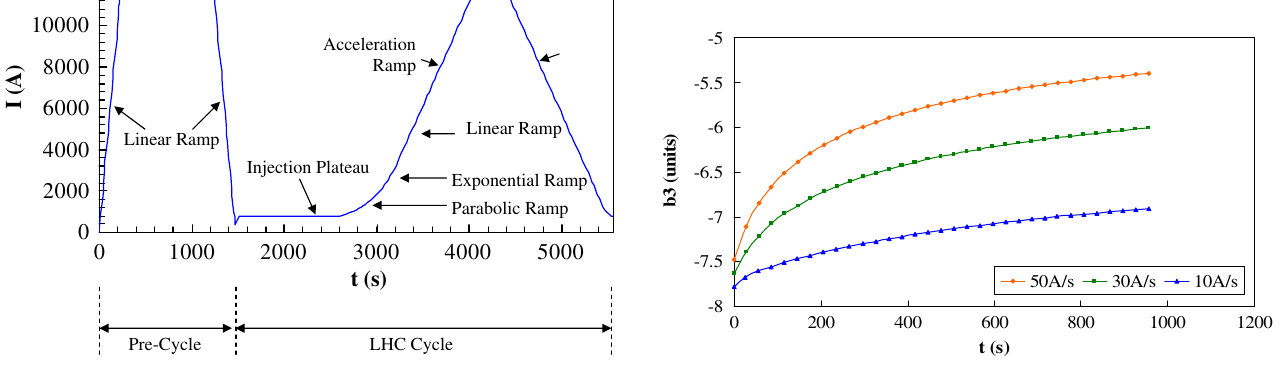
FIG. 2. (Color) The LHC cycle used for series magnetic mea- surements of the LHC dipoles.